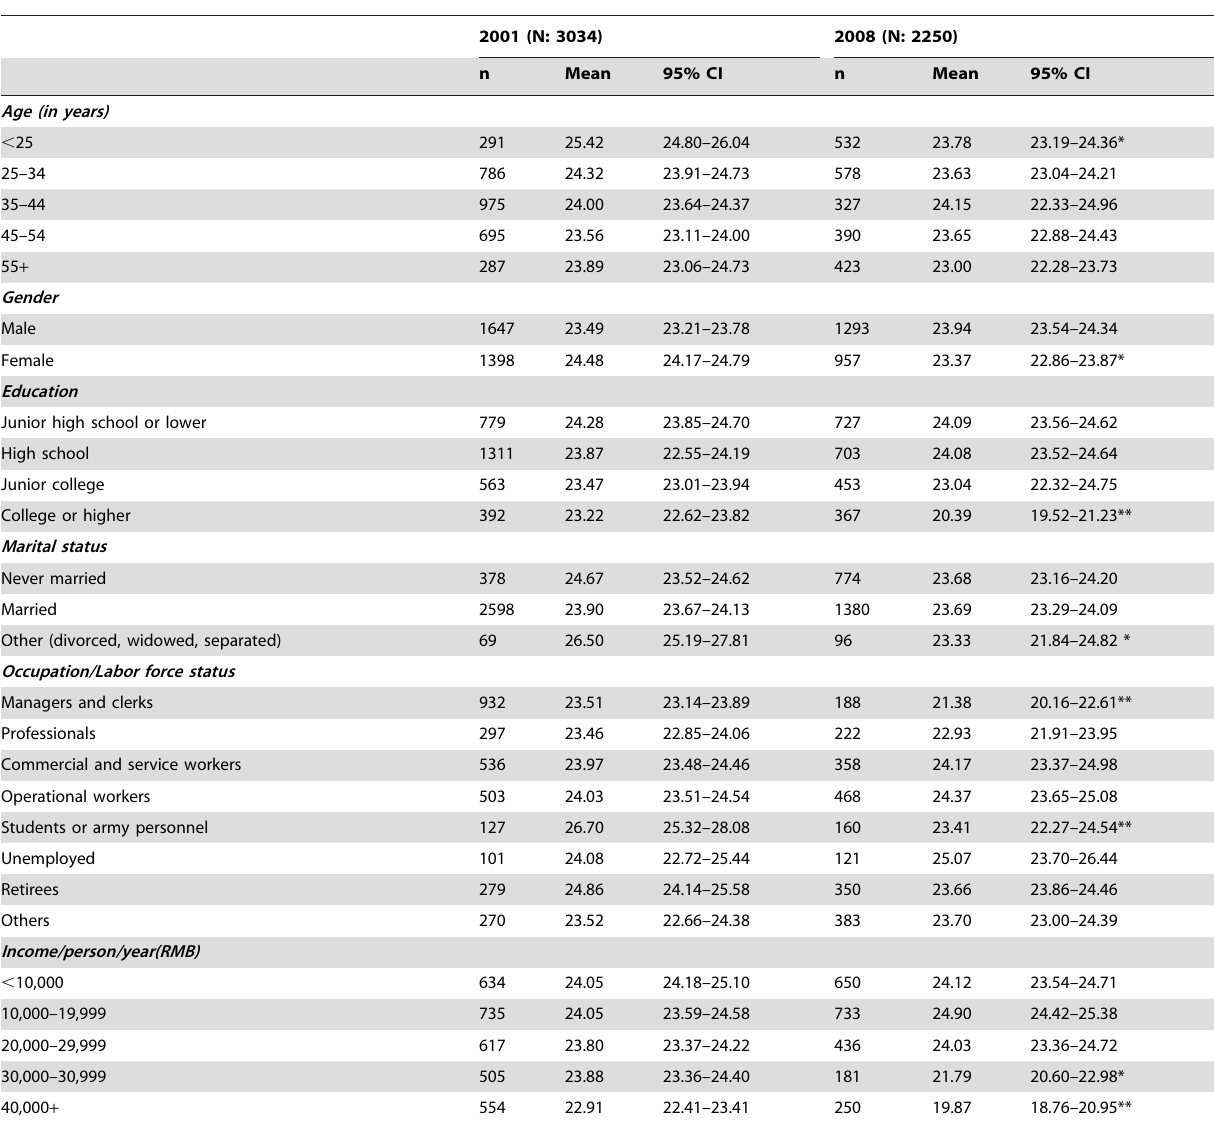
Table 2. Mean stress scores of combined residents from three large capital cities by demographic characteristics, 2001 and 2008 #